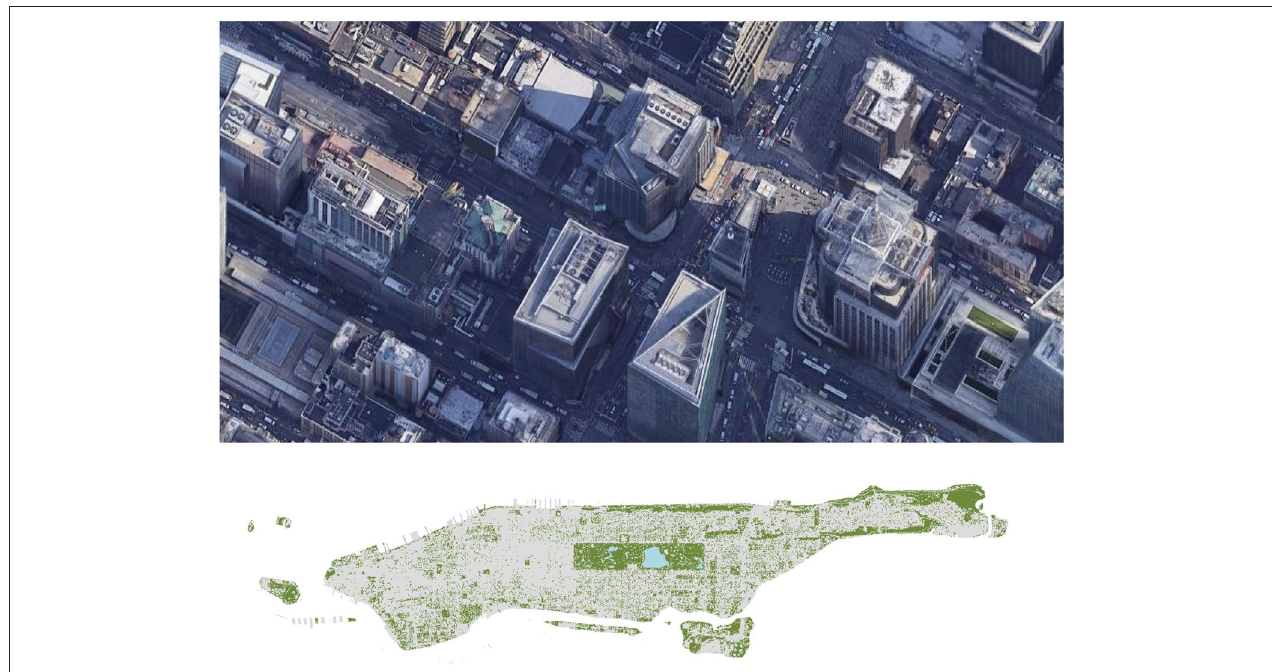
FIGURE 1 | At top, a satellite image of Times Square in Manhattan. In this image, the only visible green habitat is a small green rooftop on the Stephen Sondheim Theater (at far right). As a result, the living biomass of this part of Manhattan is nearly entirely human and part of the gray habitat. Image courtesy of Google Earth. At bottom, a view of all the major green habitats in broader Manhattan as well as the more expansive gray habitats that surround them. In the green parts of the city, plant biomass dominates; in the gray parts of the city, human biomass does (Department of Information Technology Telecommunication,